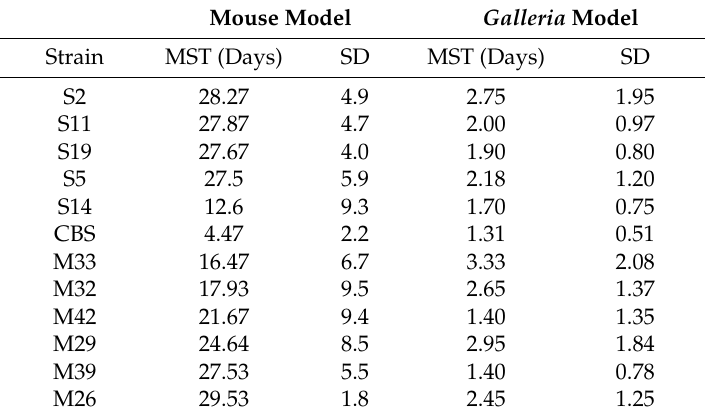
Table 2. Comparison of pathogenicity of Candida albicans strains in mouse and Galleria mellonella